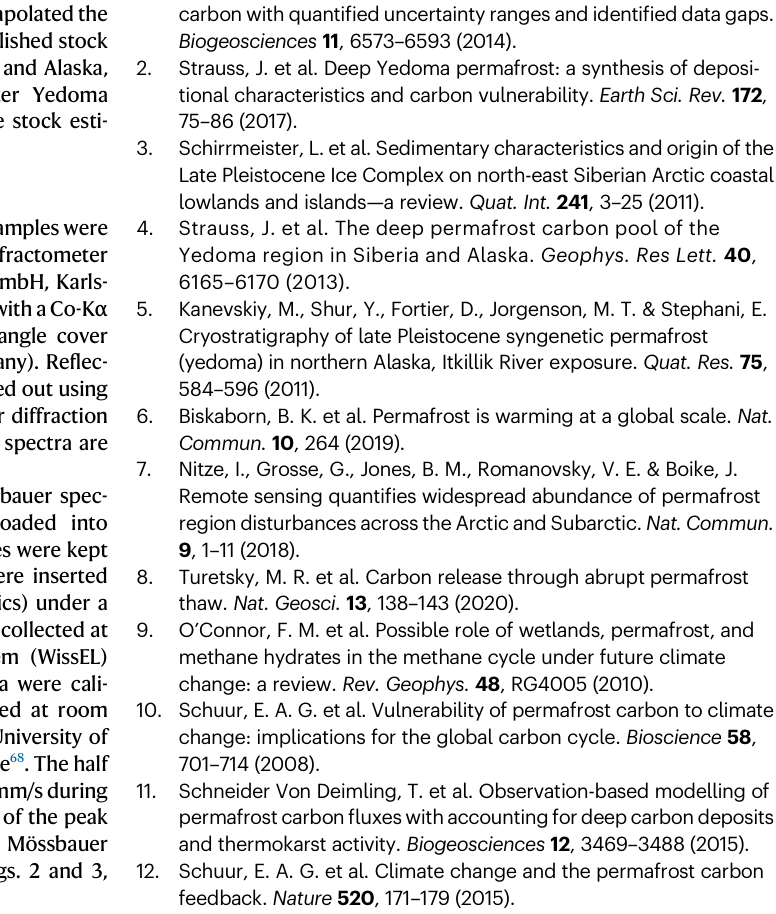
Supplementary Table 7 and expressed as mean± 1-sigma uncertainty µ